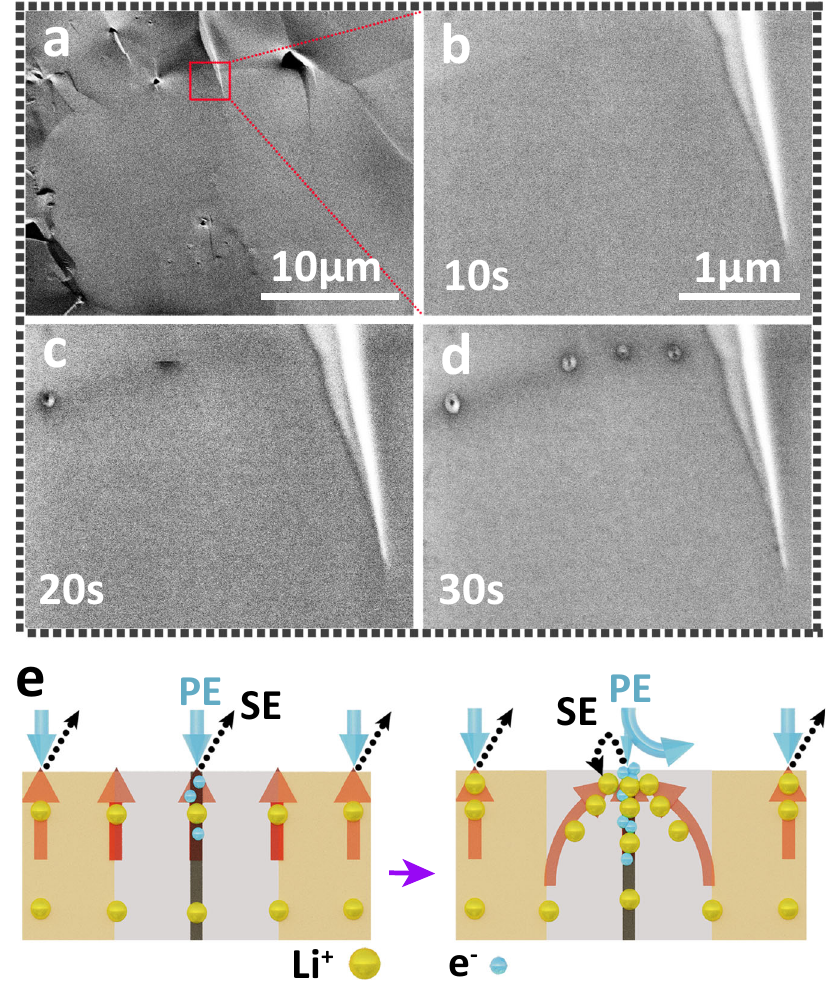
Fig. 5 | Negative charge effects in grain boundaries. a SEM image of a cross- section of LLZO freshly prepared. b – d Changes of LLZO grain boundaries in the